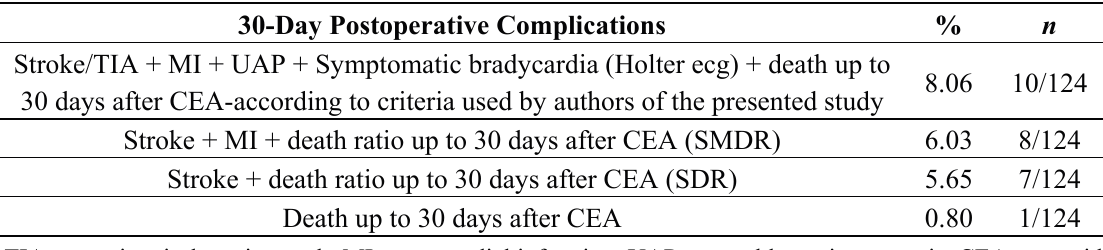
Table 3. Thirty-day complications in the study group ( n = 124)—According to extended criteria used by the authors of this study and in published